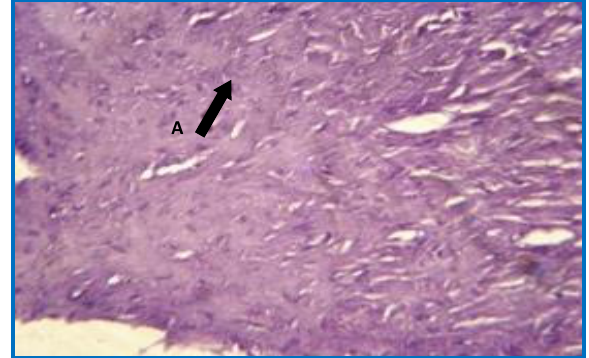
Figure, 11: There is mature fibrous connective tissue in the stroma (A). 11: Group B, fifteen days post operation, (H and E